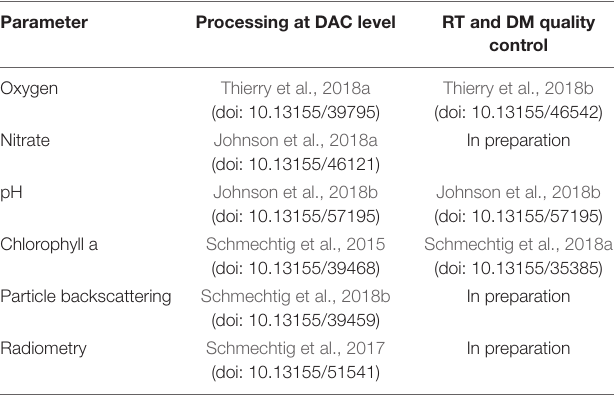
TABLE 6 | Overview about BGC-Argo documentation for the 6 core BGC